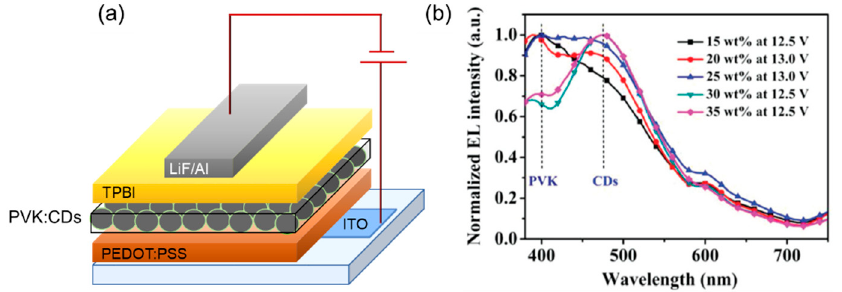
Figure 20. ( a ) Device architecture and ( b ) normalized EL spectra for different CD-doped devices: Reproduced with permission from [81], copyright 2020 Wiley-VCH Verlag GmbH & Co.